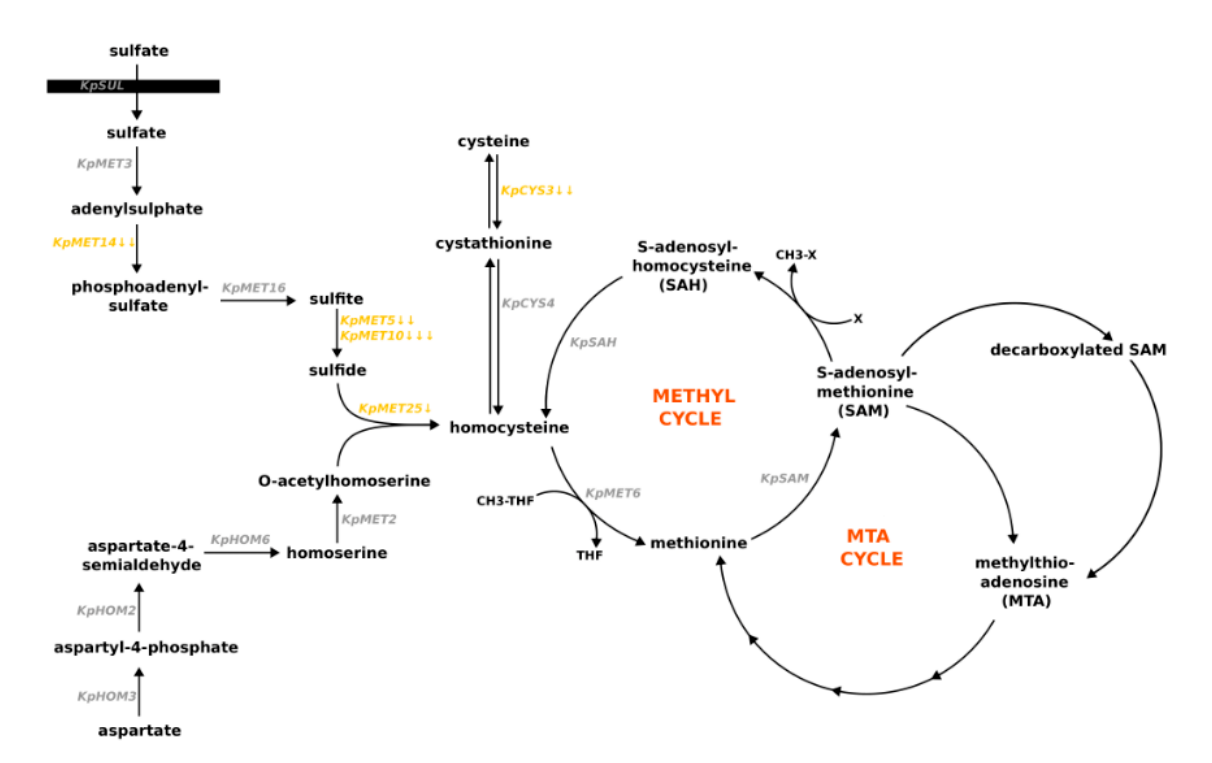
Figure 2. Scheme of proposed methionine metabolism pathways in K. phaffii cells (based on data for S. cerevisiae [37,59]). Genes are placed near the reactions catalyzed by the corresponding proteins. Genes that are repressed in media with methionine are marked in orange. Genes that do not change their expression are marked in grey. The number of arrows represents values of the log2FoldChange parameter: one arrow 0.5 < log2FoldChange < 1; two arrows 1 < log2FoldChange < 2; three arrows 2 < log2FoldChange.